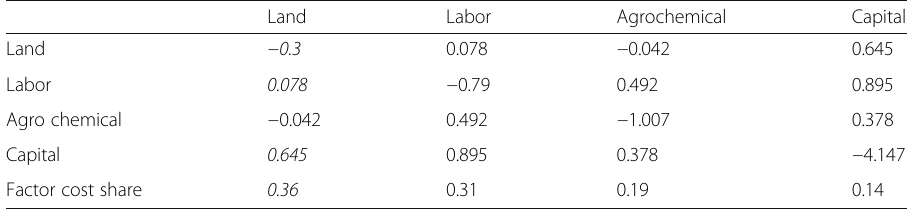
Table 6 Allen elasticities and cost shares Land